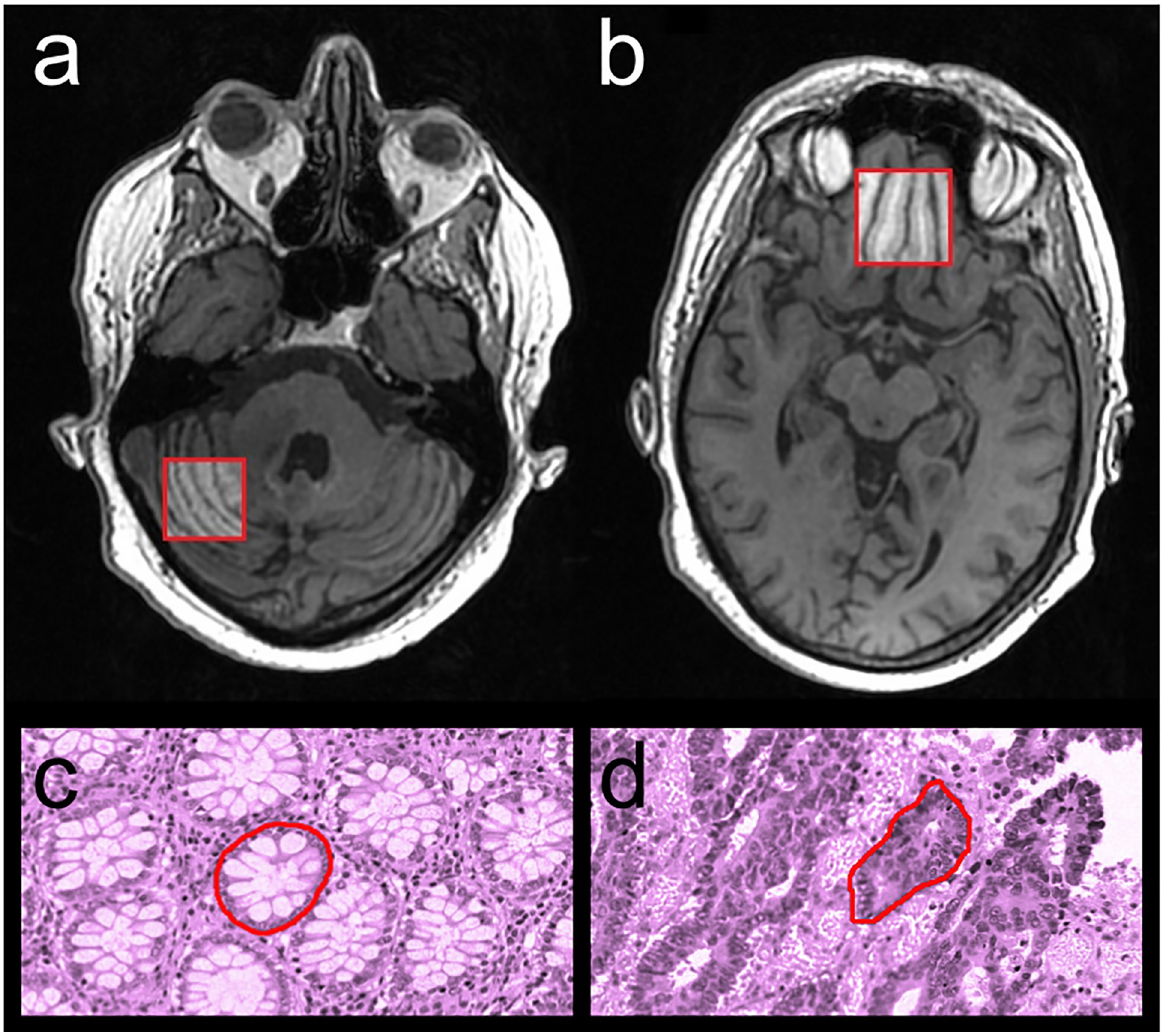
Fig 3. The image data used to test the invariant features in classification problems. Texture features were computed for a range of quantization gray-levels from a region in the cerebellum (a) and a region in the prefrontal cortex (b), and from benign (c) and malignant (d) colorectal glandular